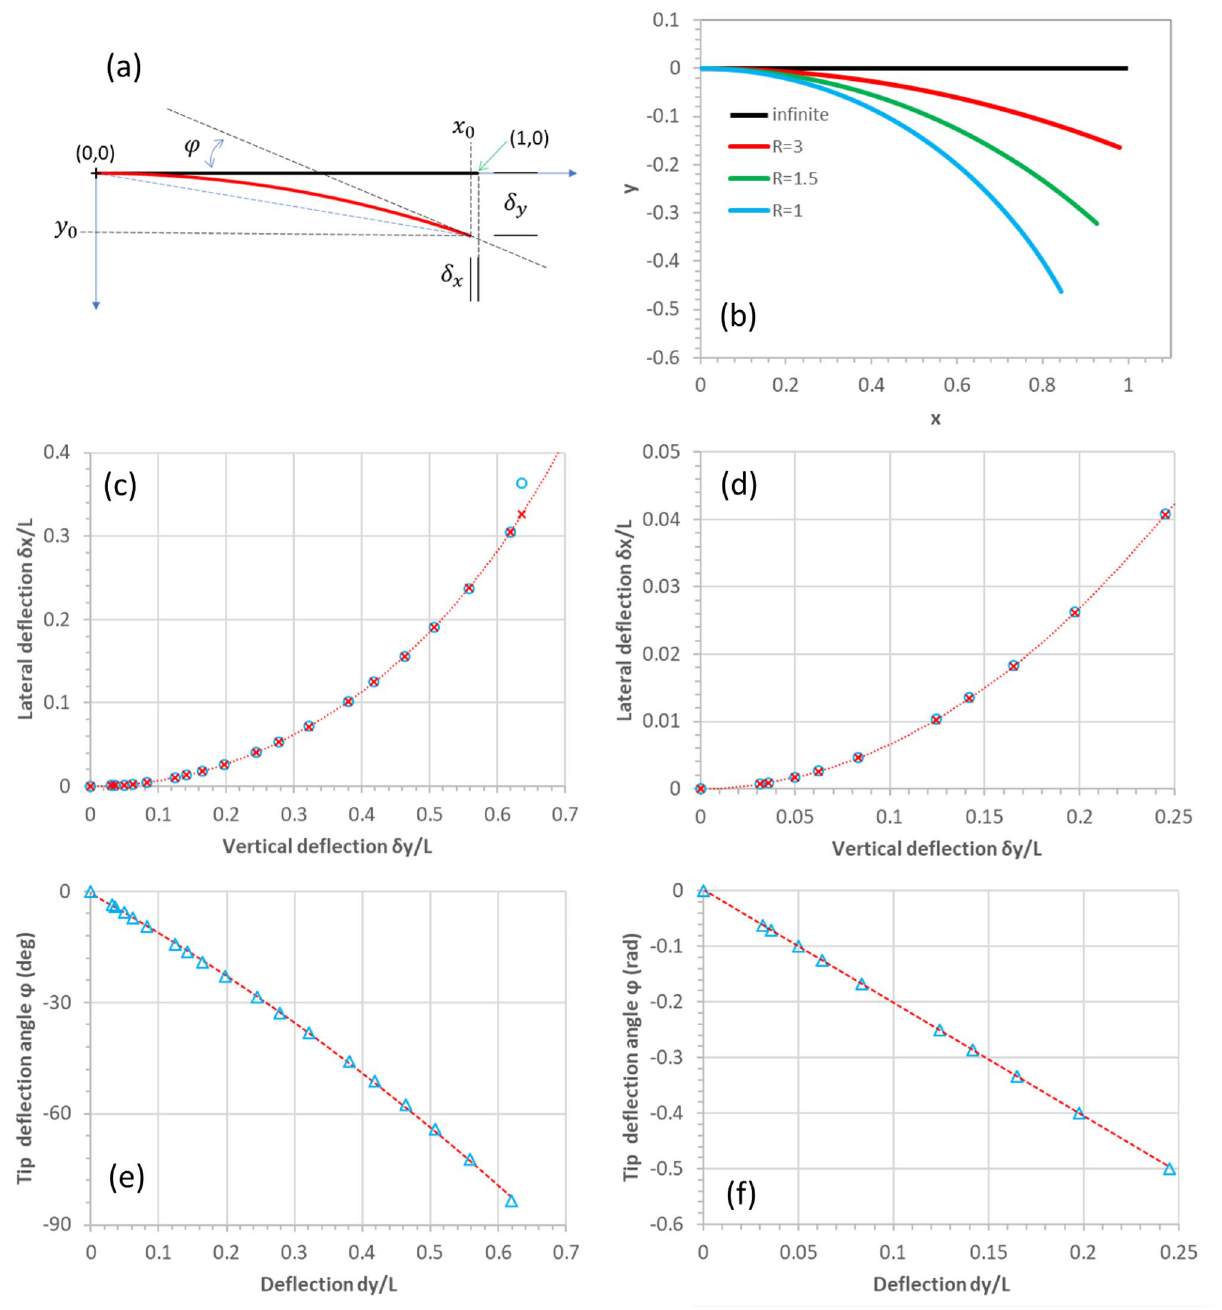
Figure 12. Modelling of a triangular cantilever bending in high deflection. ( a ) Schematic diagram showing the side view of a deflecting triangular cantilever under a concentrated load at the tip. ( b ) The modelled profile of the triangular cantilever of unit length undergoing deflection at various bending radii. ( c ) The modelled lateral deflection of the tip as a function of vertical deflection. ( d ) A zoom of graph ( c ). ( e ) The tip deflection angle versus the tip deflection. ( f ) A zoom of graph ( e ) showing the quasi-linear on rectangular microcantilevers 11 . To do this, the overtravel should not be vertical but rather follow the arc of the tip deflection, i.e. the δ y versus δ x relationship given by Eq. (7). Figure 17 shows schematically the idea of attaining zero-skate for a tapered probe—this could be accomplished using a specially-designed mechanical part or stepper motors.